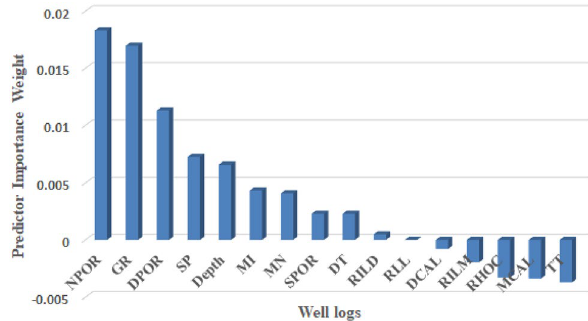
Fig. 6 Available well logs arranged according to their predictor important weights assigned by Relief algorithm for pattern recogni- tion of